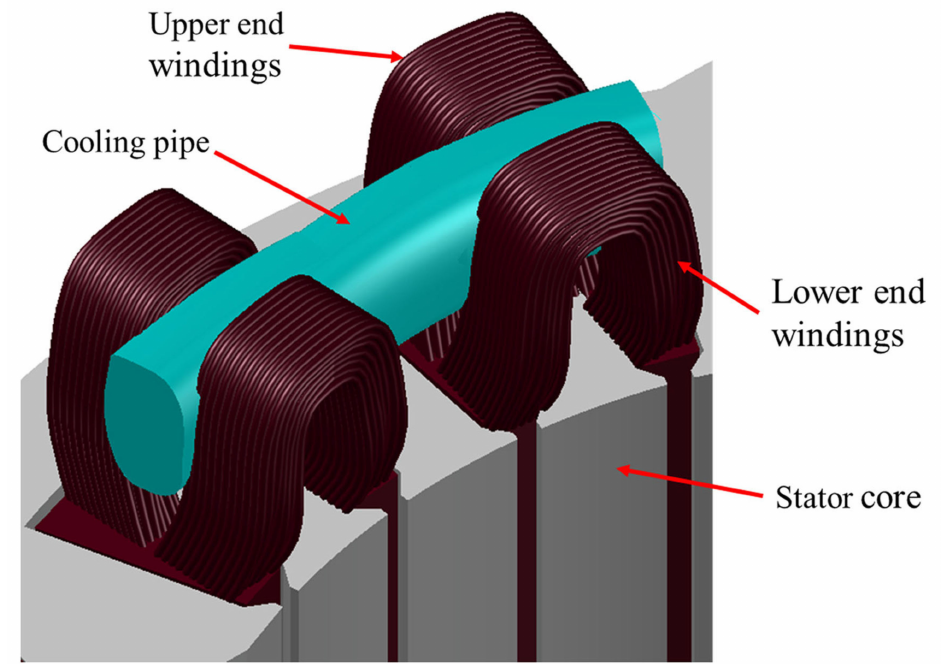
Figure 23. Split end-windings with cooling pipe passing through